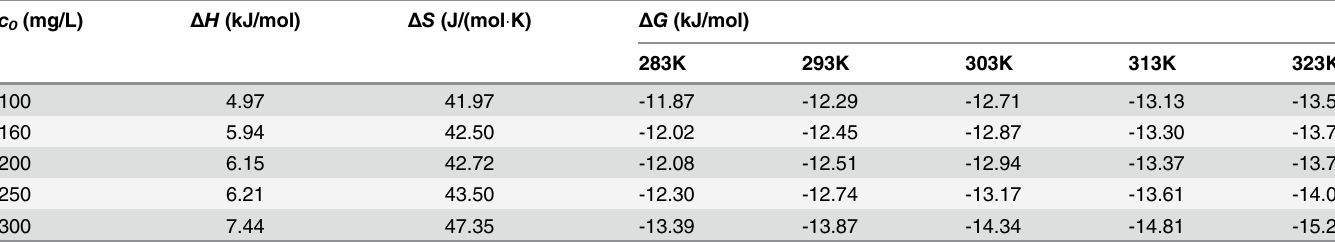
Table 3. The thermodynamics parameters of the adsorption for reserpine onto the SACEF. c 0